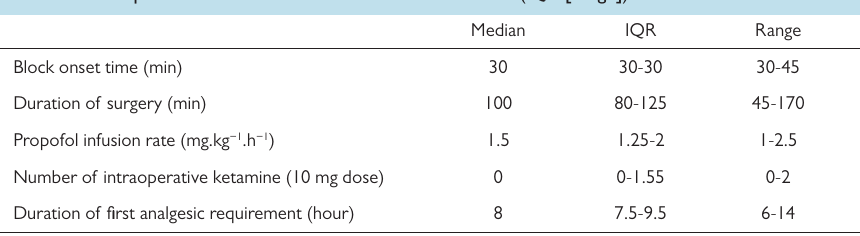
Table 2. Perioperative outcome measures. Values are median (IQR [range])